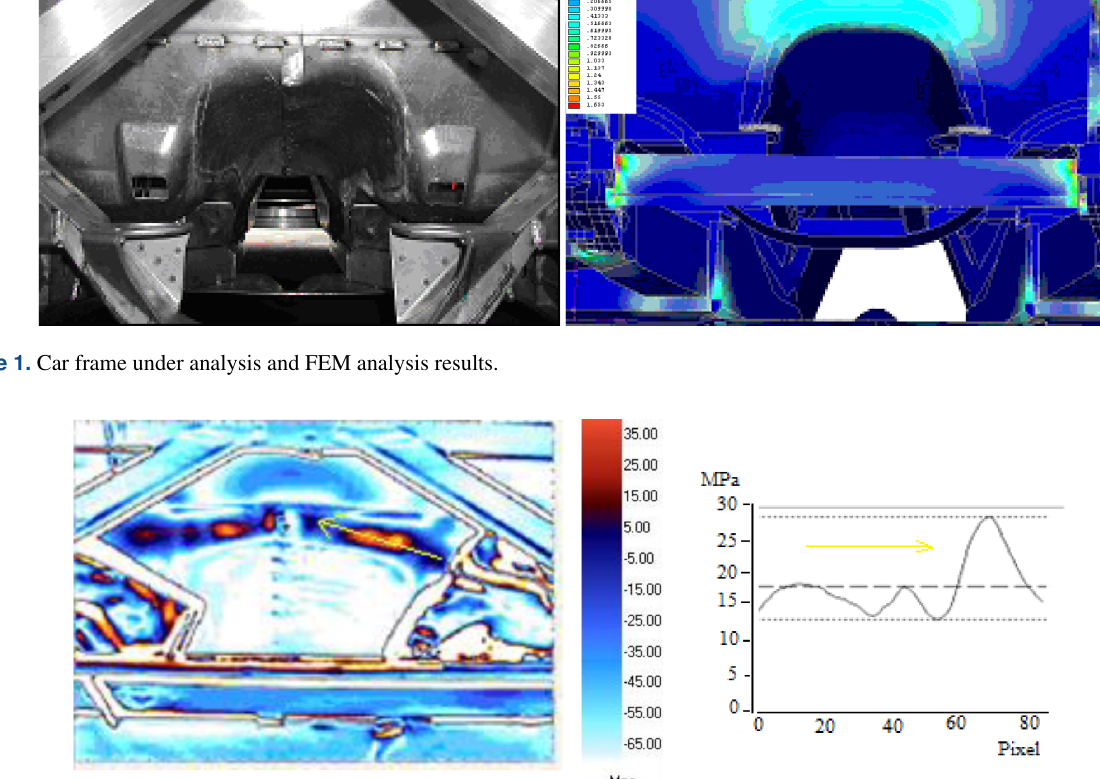
Figure 2. Typical thermoelastic